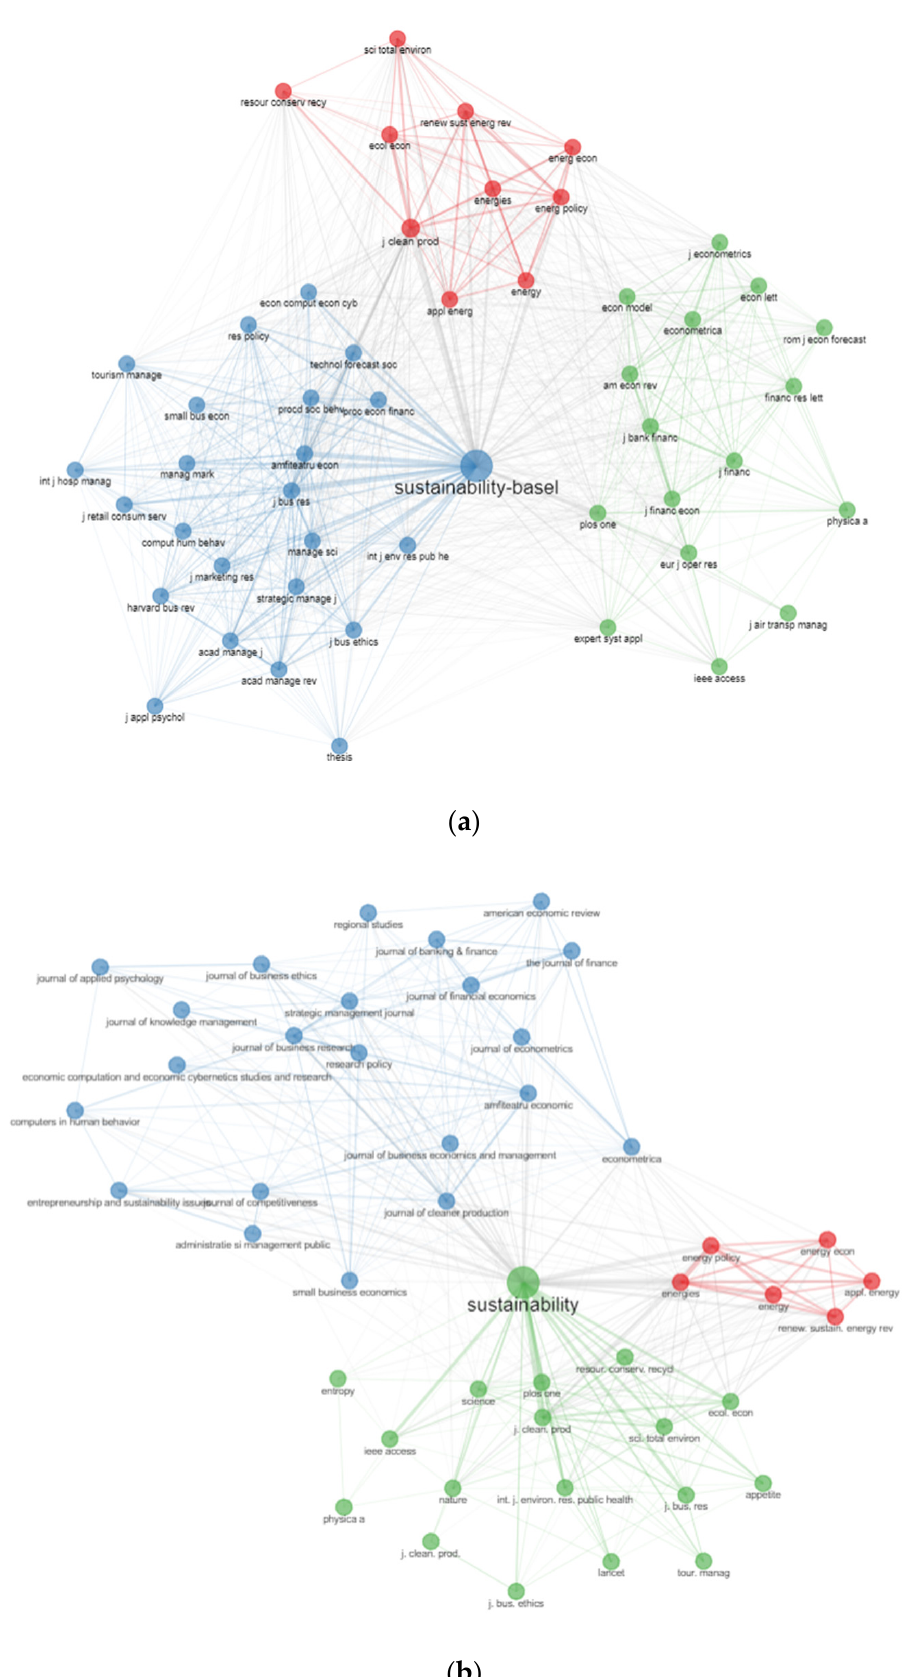
Figure 15. Cooccurrence network analysis in journals. ( a ) WoS. ( b ) Scopus.